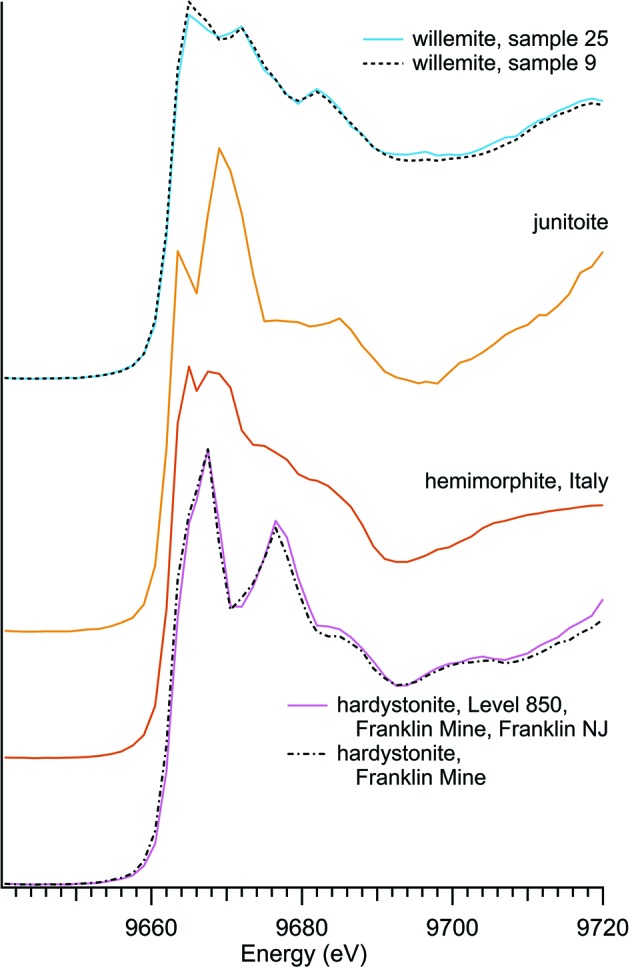
Zinc silicate spectra.